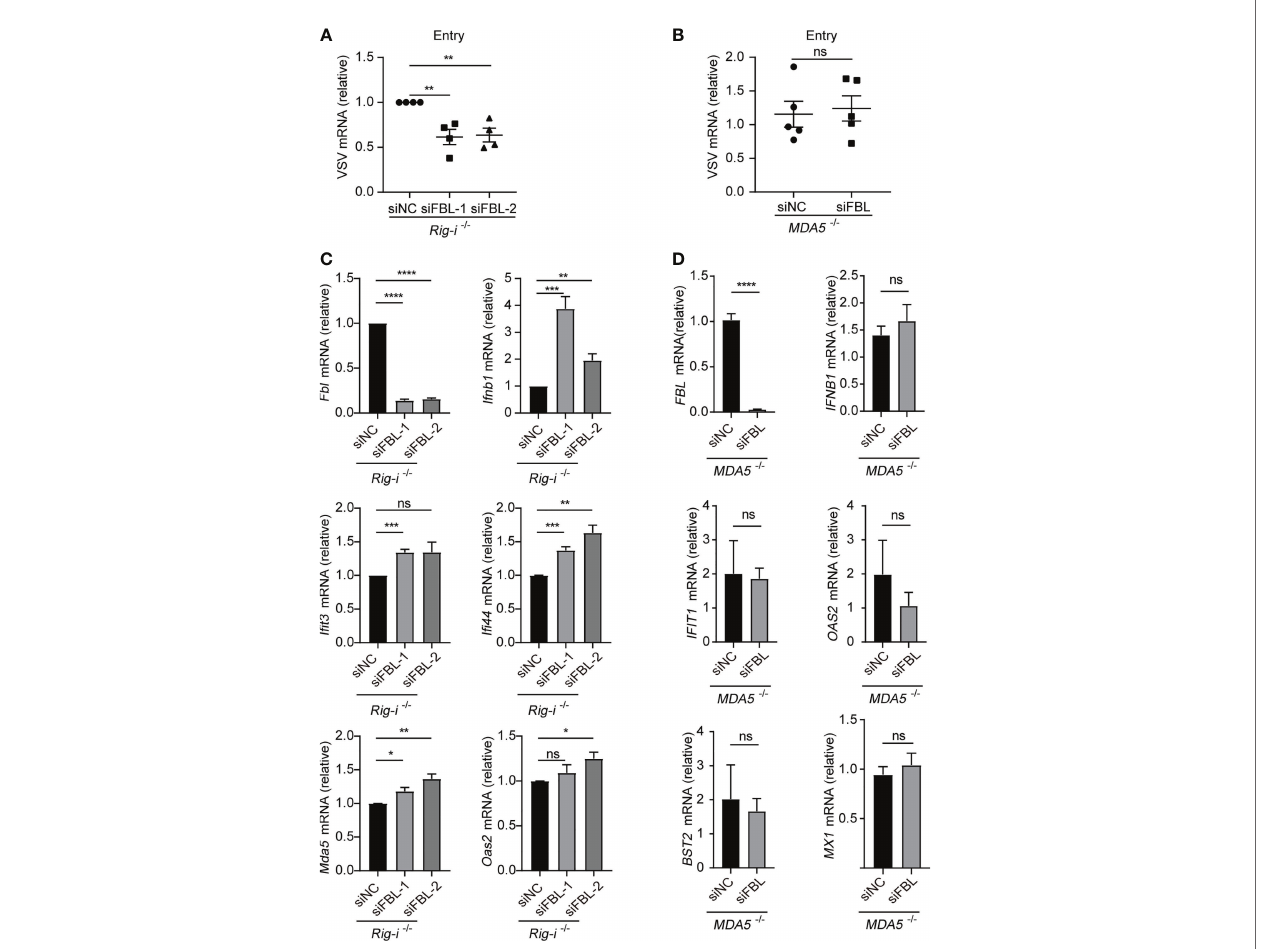
FIGURE 7 | FBL de fi ciency increases IFN-I signaling and ISGs expression via RNA sensor MDA5 (A) VSV RNA levels in Rig-i -/- mouse peritoneal macrophages transfected with the indicated siRNAs for 48 h and then infected with VSV for 30 min in 4°C. After removal of unbound virus, the temperature was increased to 37°C to allow internalization. Then quantify VSV RNA levels via qRT-PCR (n=4); (B) VSV RNA levels in MDA5 -/- A549 cells transfected with the indicated siRNAs for 48 h and then infected with VSV for 30 min in 4°C. After removal of unbound virus, the temperature was increased to 37°C to allow internalization. Then quantify VSV RNA levels via qRT-PCR (n=5); (C) qRT-PCR analysis of Fbl , Ifnb1 , I fi t3 , I fi 44 , Mda5 , Oas2 mRNA in Rig-i -/- mouse peritoneal macrophages transfected with the indicated siRNAs for 48 h (n=3); (D) qRT-PCR analysis of FBL , IFNB1 , IFIT1 , OAS2 , BST2 , MX1 mRNA in MDA5 -/- A549 cells transfected with the indicated siRNAs for 48 h (n=6). Data are mean ± SEM of biologically independent samples. ns, not signi fi cant, * P <0.05, ** P <0.01, *** P <0.001, **** P <0.0001, two-tailed unpaired Student ’ s t